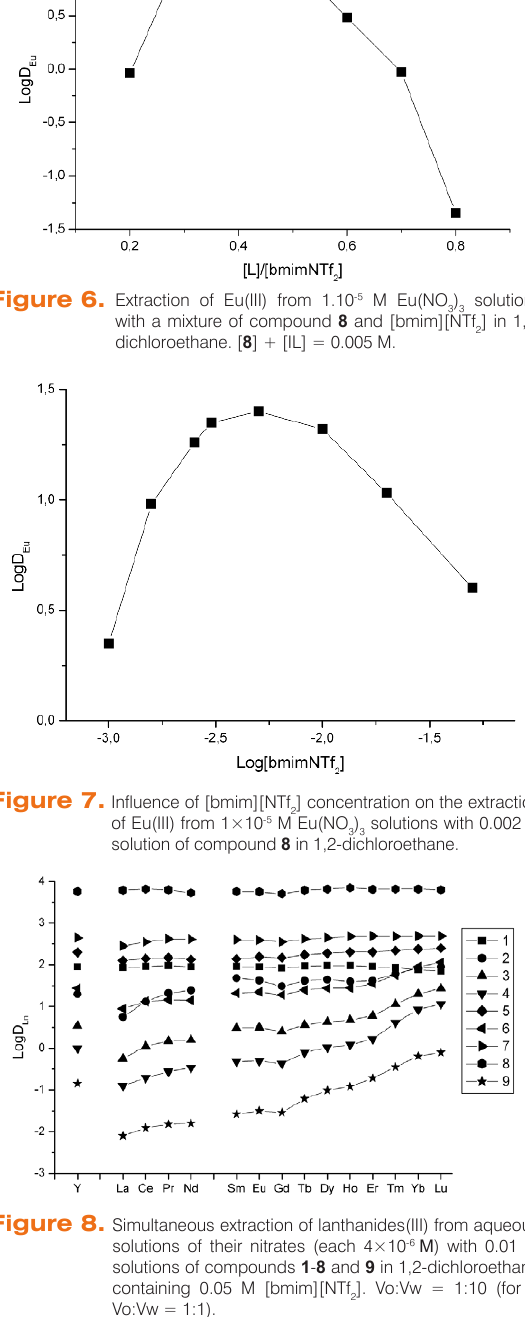
Figure 8. Simultaneous extraction of lanthanides(III) from aqueous solutions of their nitrates (each 4×10 -6 М ) with 0.01 M solutions of compounds 1 - 8 and 9 in 1,2-dichloroethane containing 0.05 M [bmim][NTf ]. Vo:Vw = 1:10 (for 9 2 Vo:Vw =